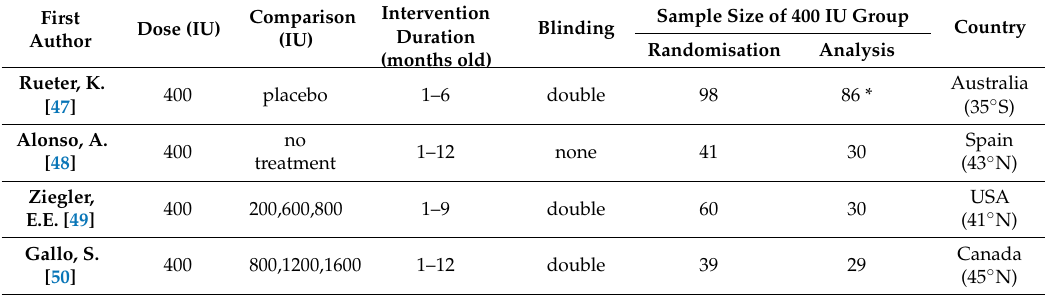
Study design, participants, and details of RCTs assessing 400 IU/day vitamin D supplementation in 1–12-month-old infants.